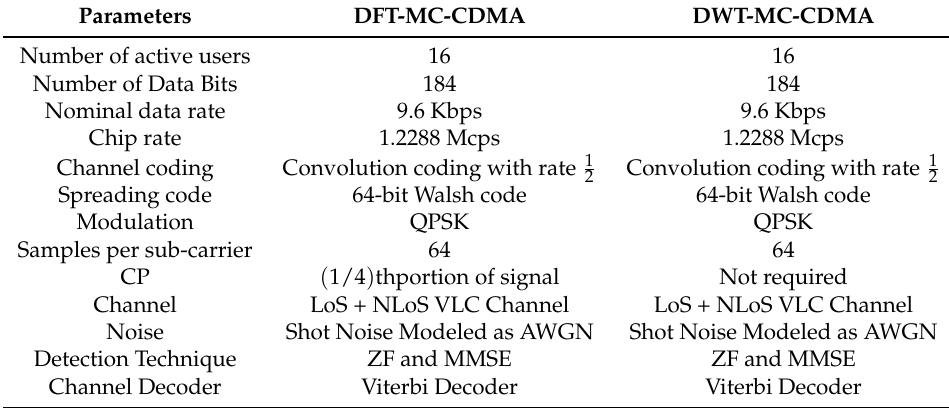
Table 2. Simulation parameters for DFT and DWT-MC-CDMA systems.